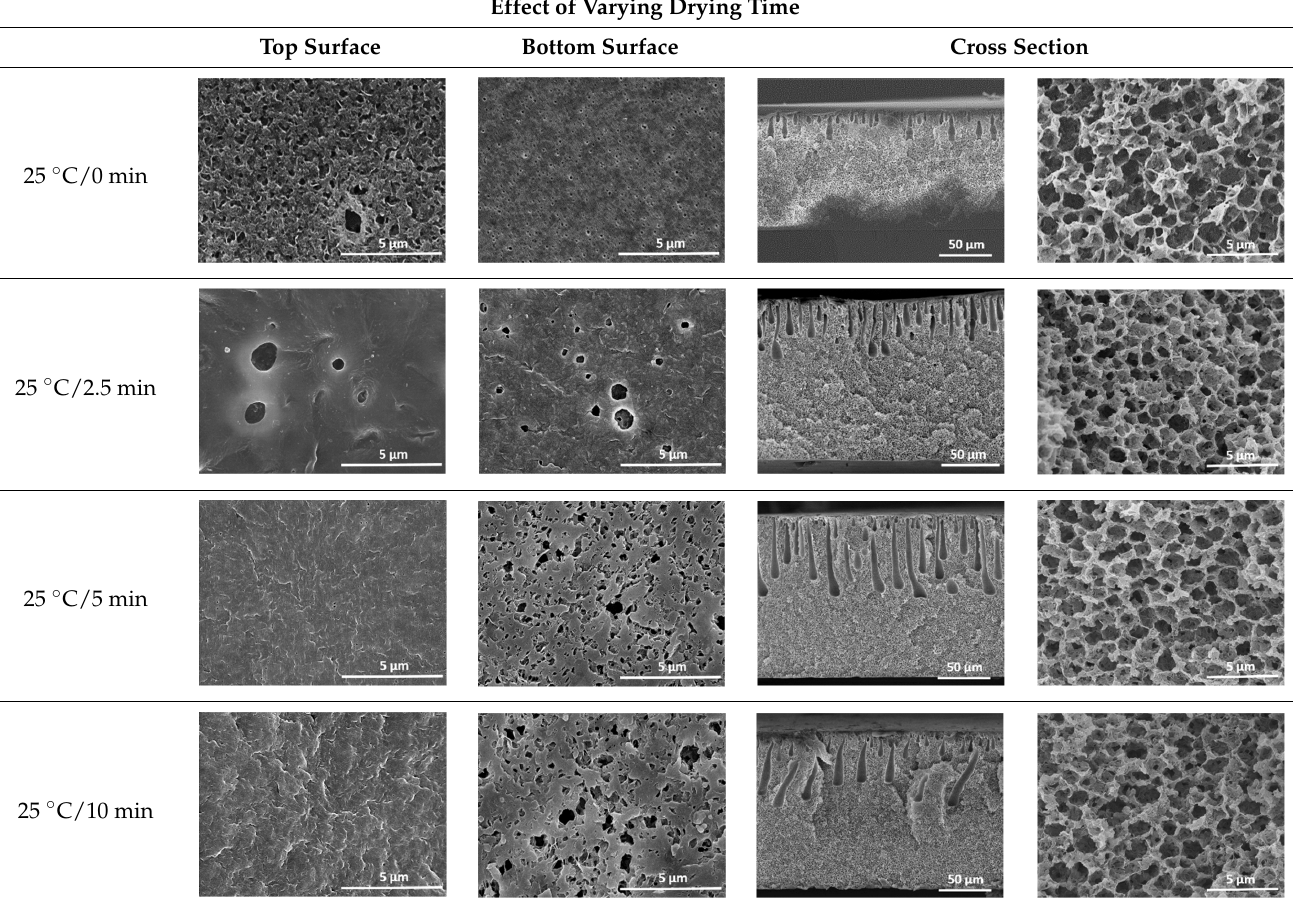
Table 2. Representative SEM images of the top and bottom surfaces and cross section of the PVDF membranes for different conditioning time.